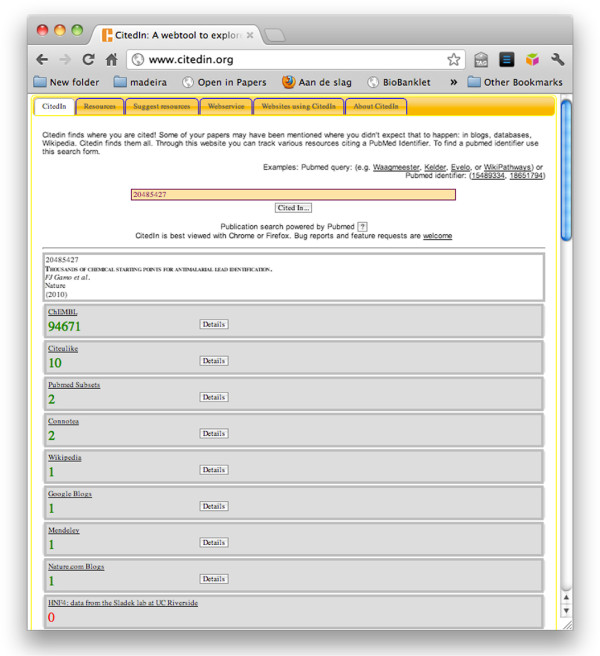
Screenshot of the CitedIn web service showing a 2010 Nature paper cited 94671 times in the ChEMBL database. The Details button on the webpage links to a ChEMBL webpage with detail on what parts of the database are linked to that paper.